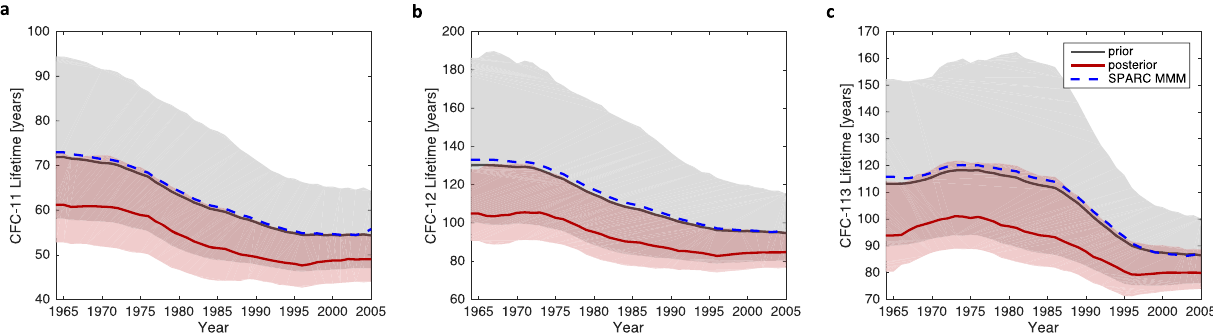
Fig. 4 Time varying lifetime distributions. The black line and grey shaded region indicate the median and 95% CI of the prior lifetimes, derived from SPARC modeled values for ( a ) CFC-11 ( b ) CFC-12, and ( c ) CFC-113. In each panel, the dashed blue line indicates the SPARC multi-model mean. The red line and shaded region indicate the median and 95% CI of the posterior lifetime